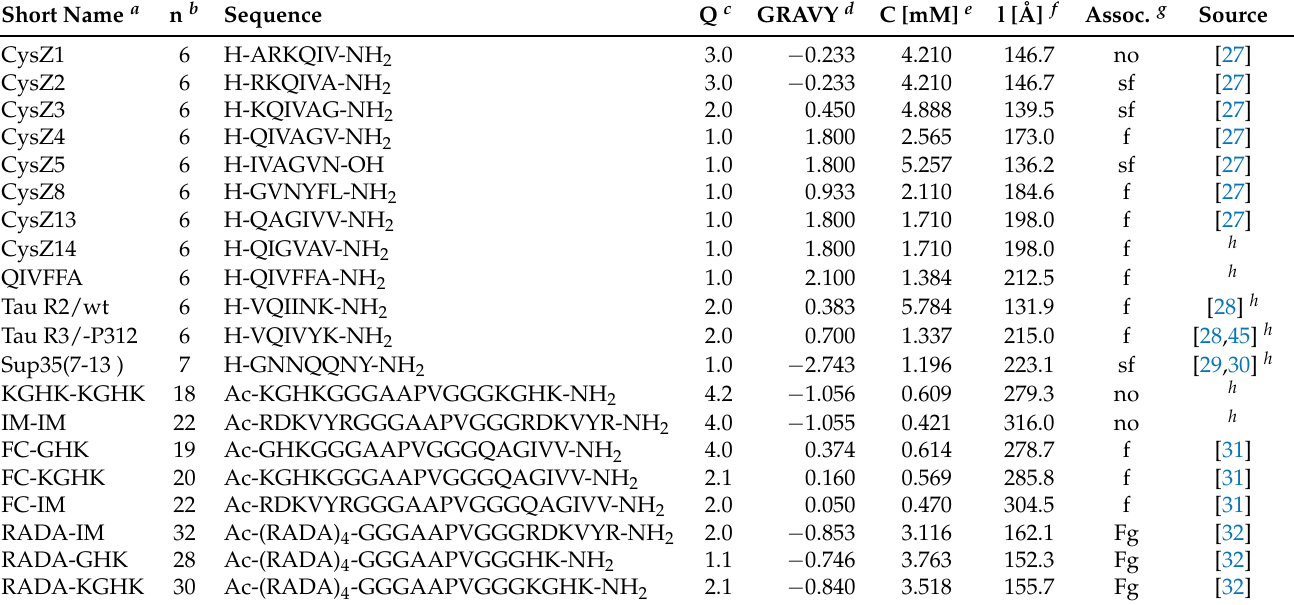
Table 1. The peptides studied in this